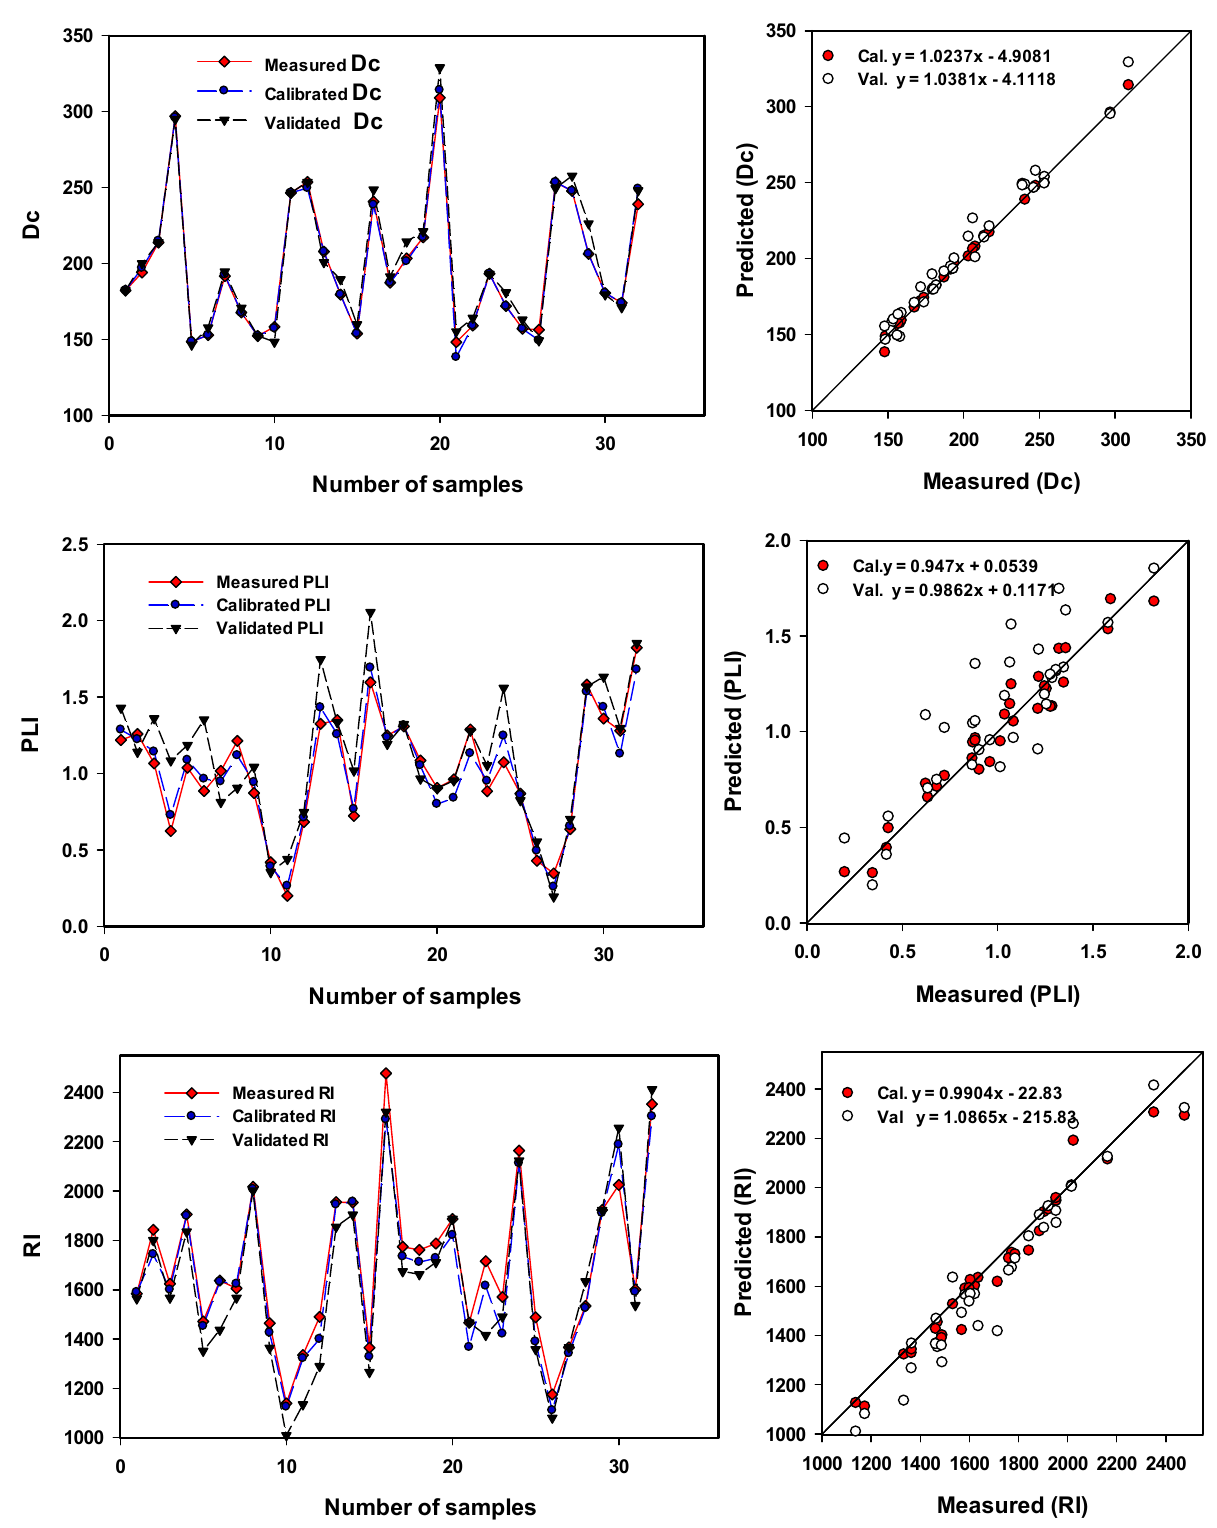
Figure 8. Comparison between measuring datasets, calibrating datasets, and validating datasets for three pollution indices index using the MLR models based on several heavy metals. Statistical analysis was showed in Table 9.